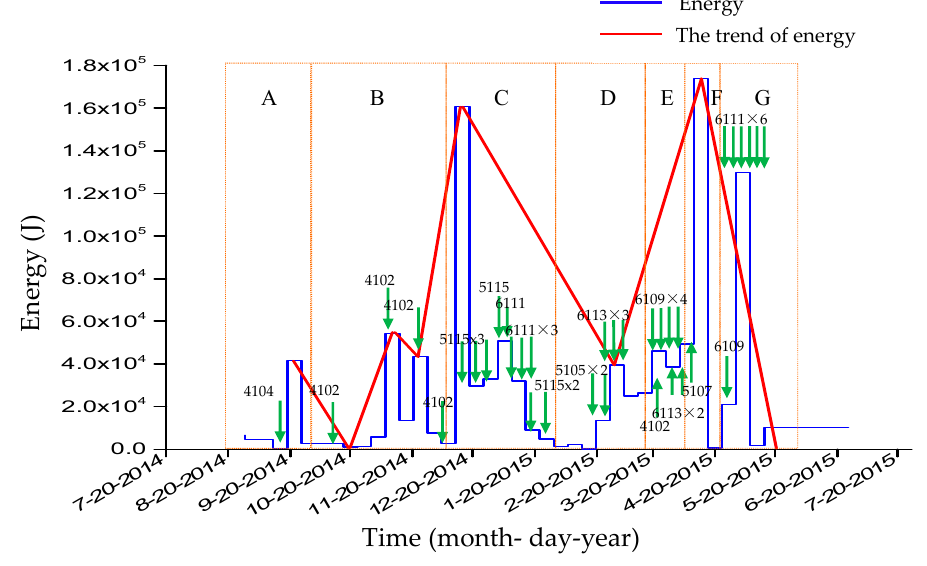
Figure 9. The variation of microseismic energy of different times: A–G represent different time intervals.